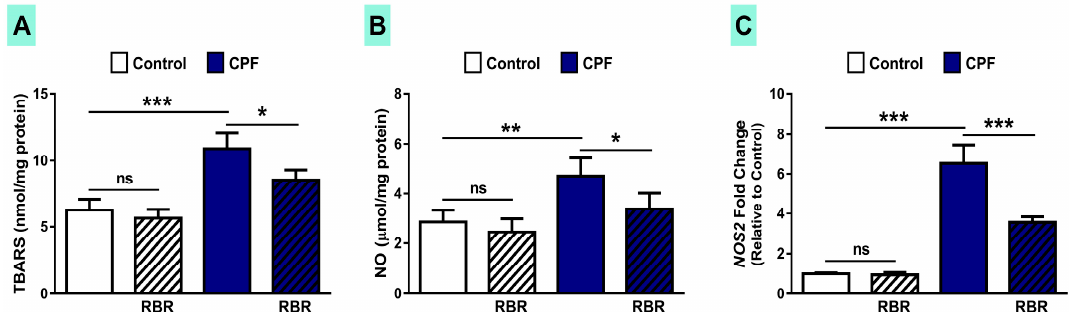
Figure 5. RBR prevents oxidative / nitrative stress and down-regulates iNOS in CPF-induced rats . RBR diminishes ( A ) TBARS, ( B ) NO and ( C ) iNOS mRNA expression in the liver of CPF-intoxicated rats. Data are mean ± SD, (N = 7). * p < 0.05, ** p < 0.01 and *** p < 0.001. ns = non-significant.